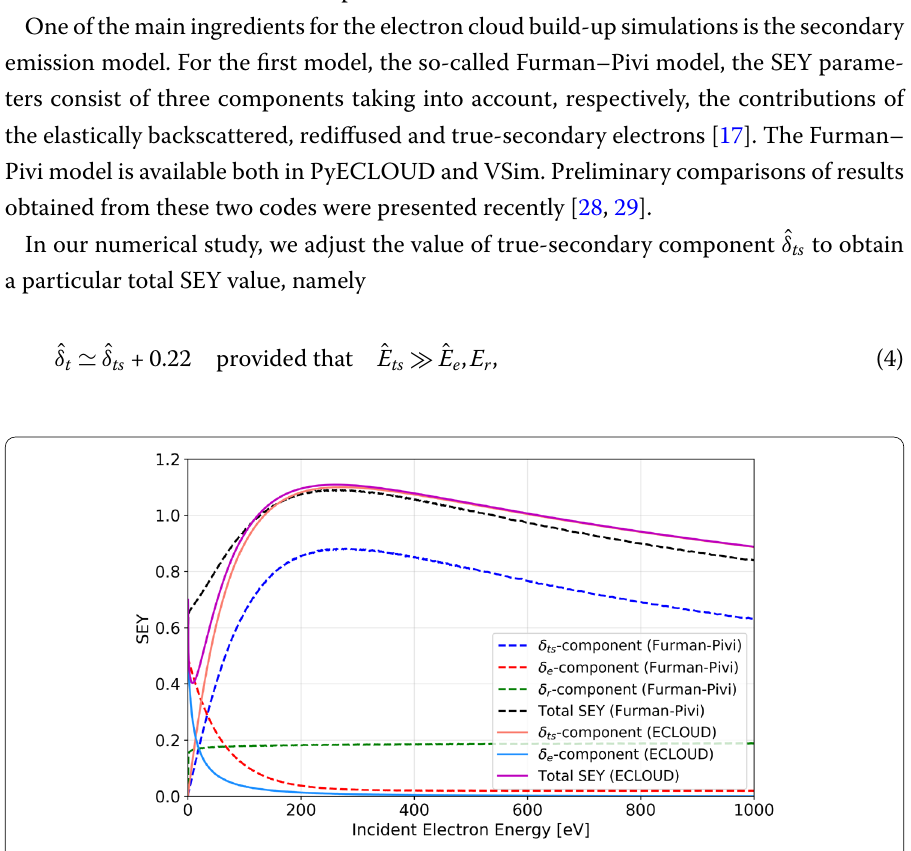
Figure 1 Composition and overall shape for the two SEY